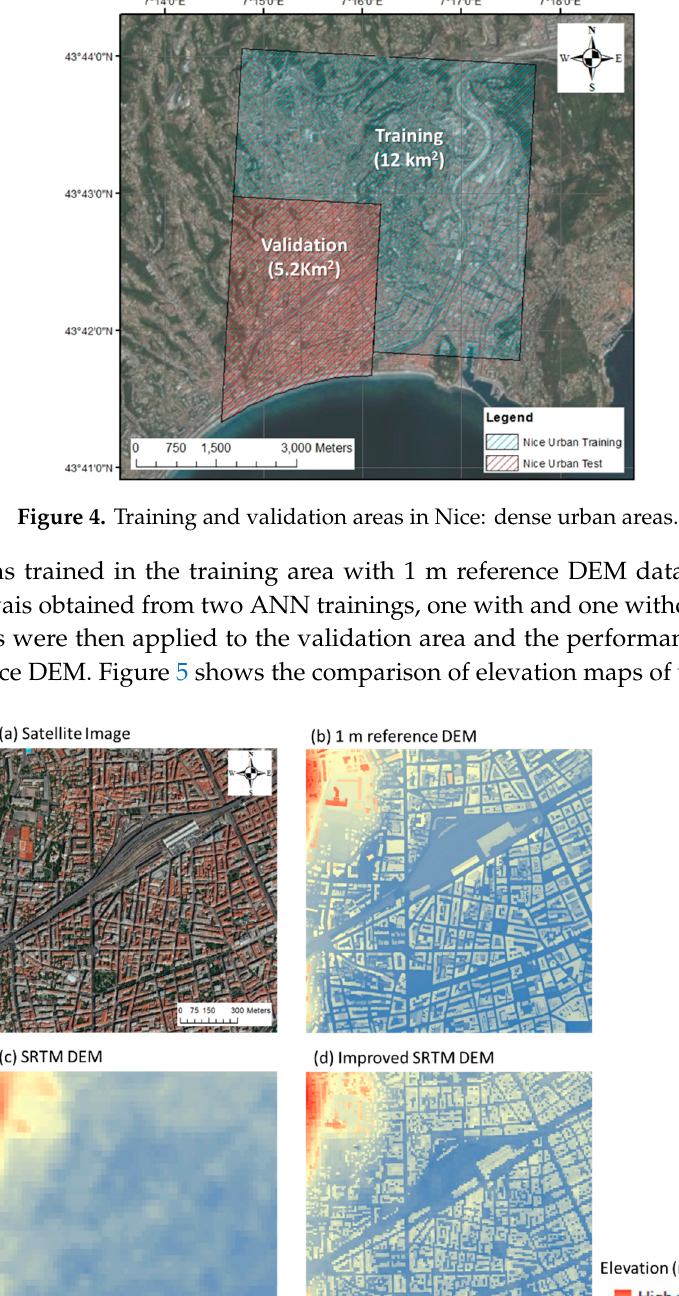
Figure 4. Training and validation areas in Nice: dense urban areas.